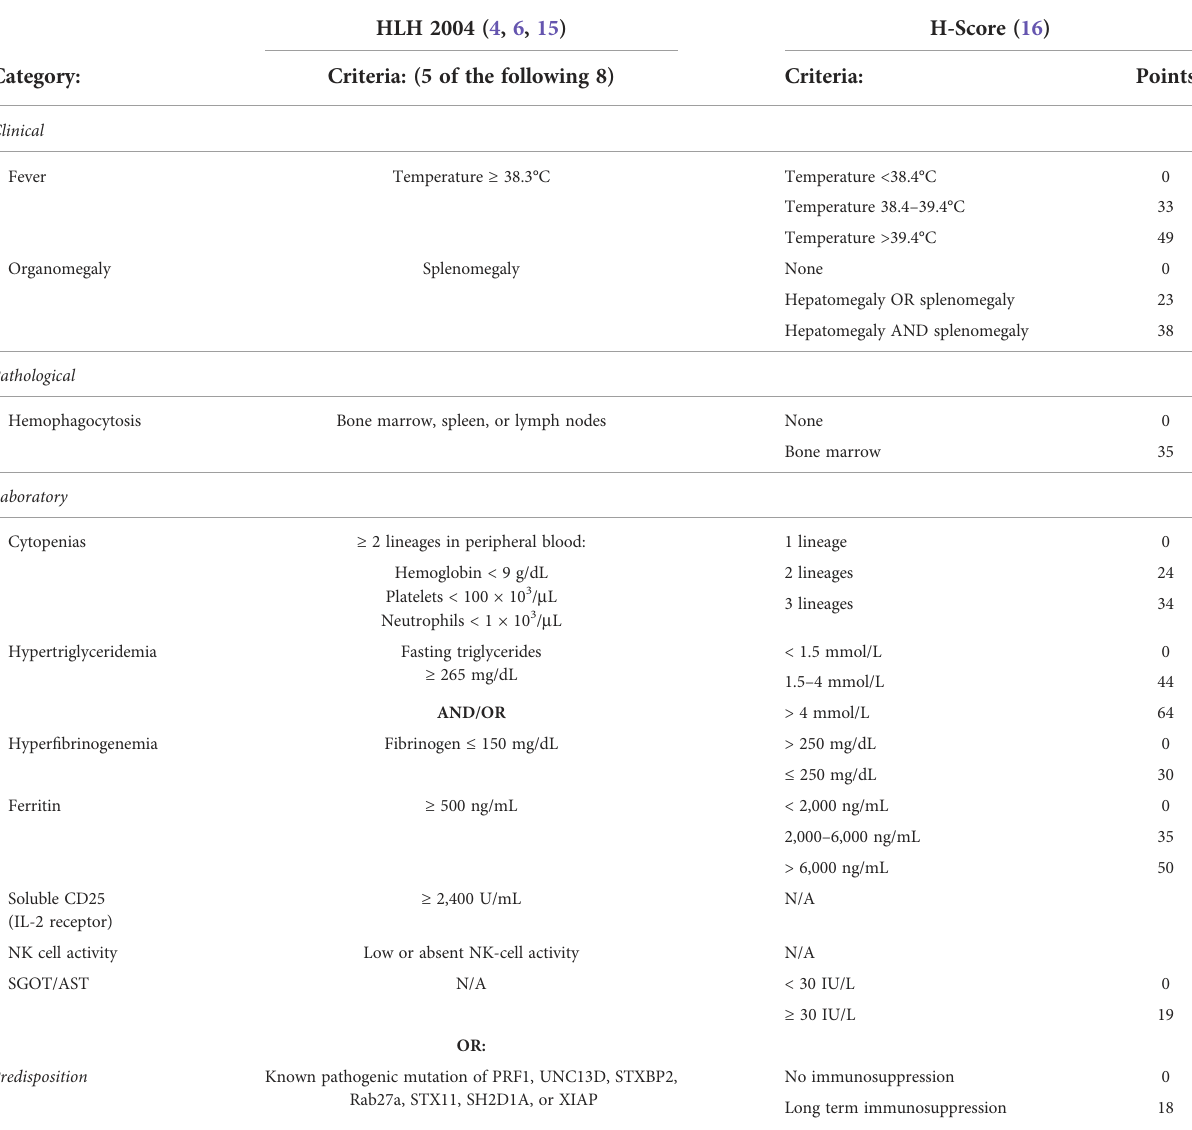
TABLE 1 Diagnostic criteria for